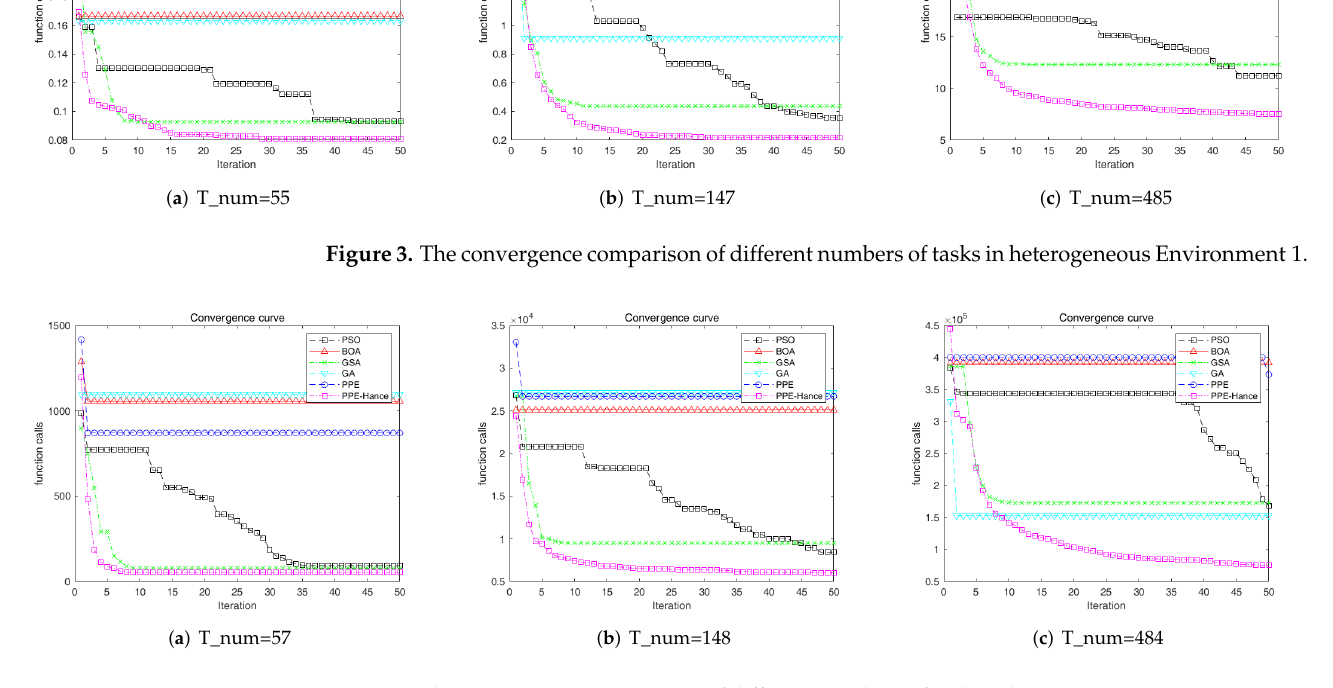
Figure 4. The convergence comparison of different numbers of tasks in heterogeneous Environment 2